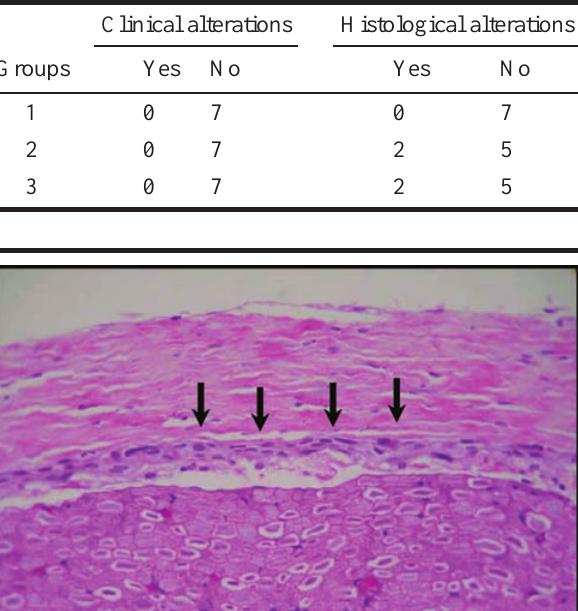
FIGURE 2 - Group 3. Segment of nerve and lumbar nervous tissues, meninges and thickness of the arachnoids (arrows). (H&E 40X)